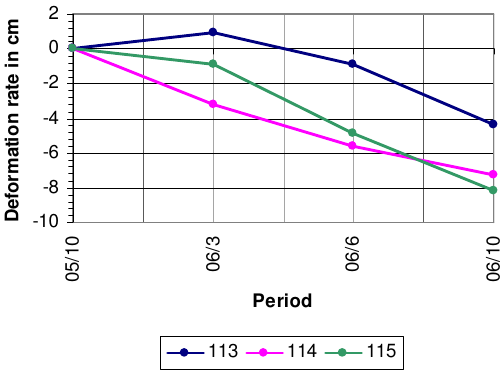
Figure 8. Temporal deformations at GPS site points in the significant deformation area. The point 112 is not listed here because it was destroyed during a building construction after the second GPS observation period. Fig. 8. Temporal deformations at GPS site points in the significant